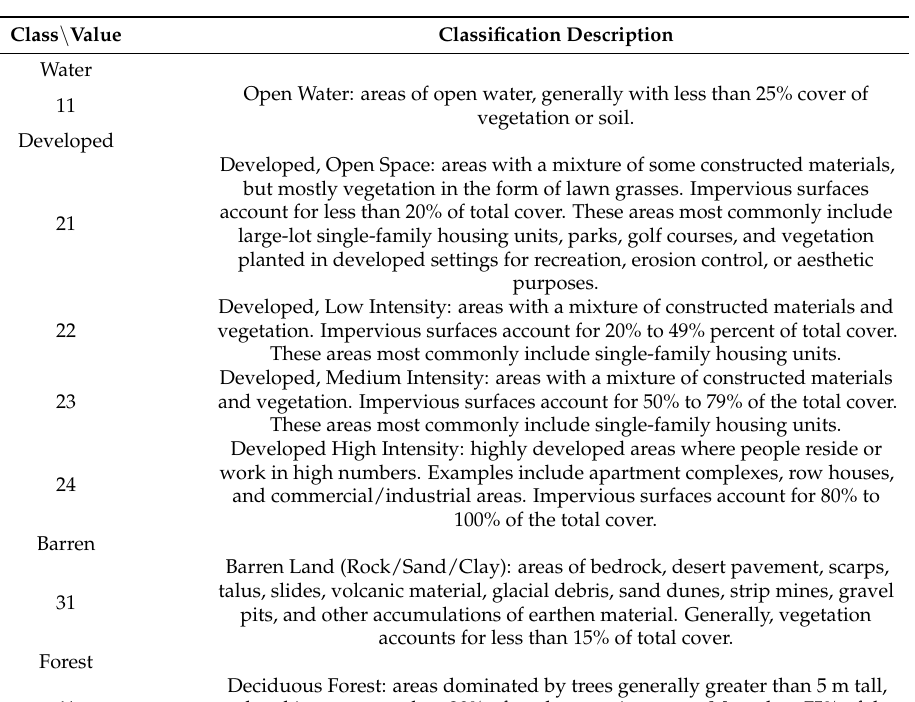
Table A7. National Land Cover Database 2016 Legend. [28]. https://www.mrlc.gov/data/legends/ national-land-cover-database-2016-nlcd2016-legend (accessed on December